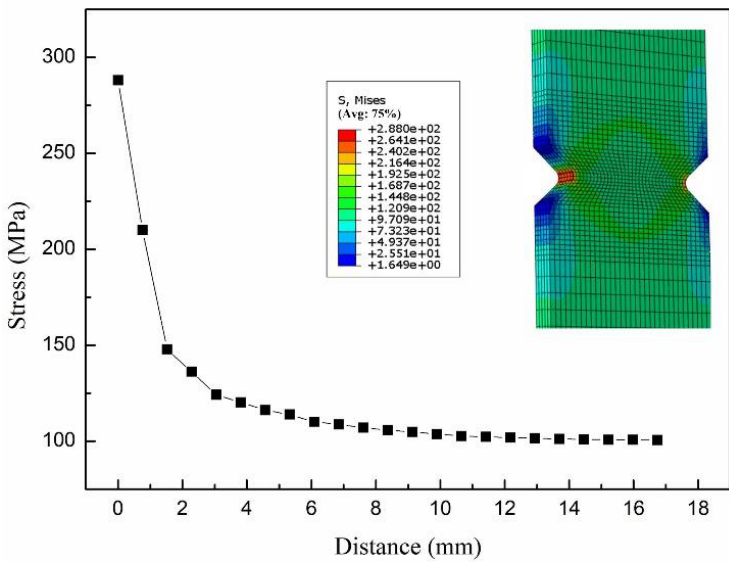
Figure 14. Stress distribution of notched specimen before shot peening.